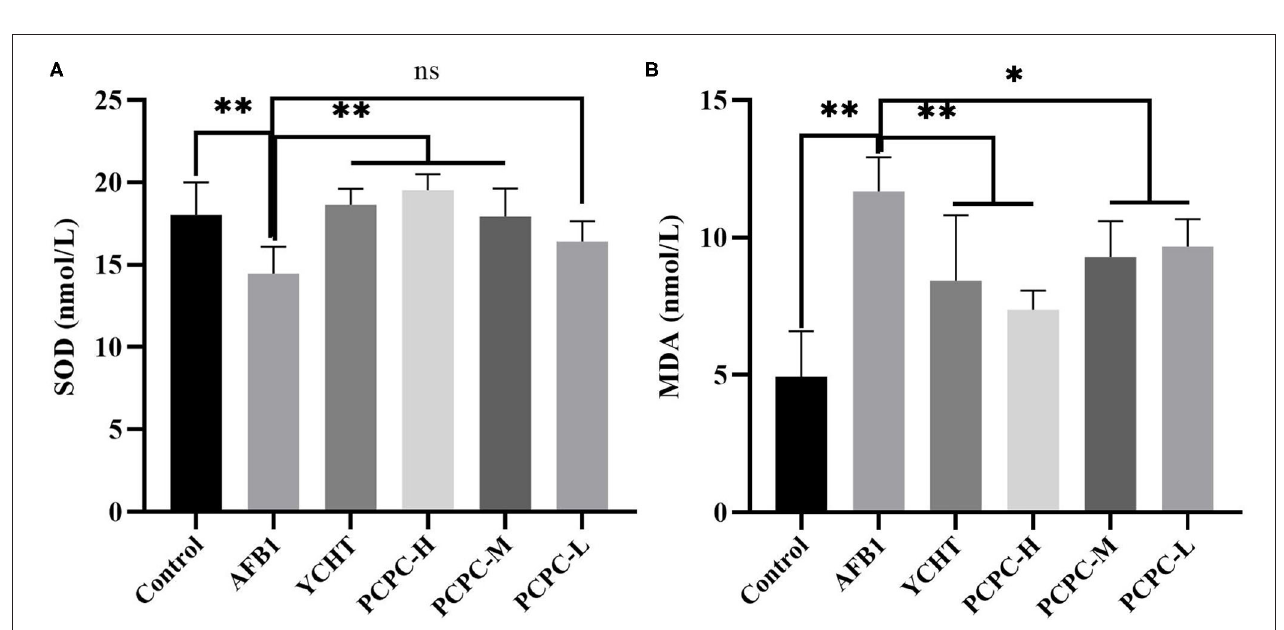
Expression Levels of NRF2 and HMOX1 in Kidneys The mRNA expression levels of NRF2 and HMOX1 in the kidneys of broilers in the AFB1 group were significantly reduced ( p